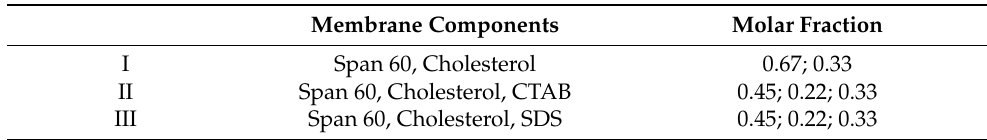
Table 1. Composition of the different nanovesicles formulated using a total concentration of mem- brane components of 50